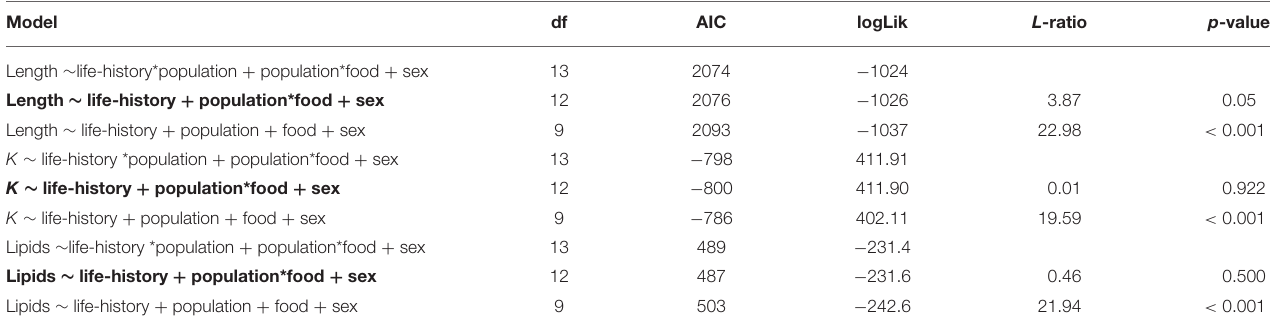
TABLE 5 | Results of the mixed effect model analysis for length, condition factor ( K ), and whole body lipids of brown trout (life-history classed as either smolts or freshwater mature) at the end of the experimental study period. Model df AIC logLik L -ratio